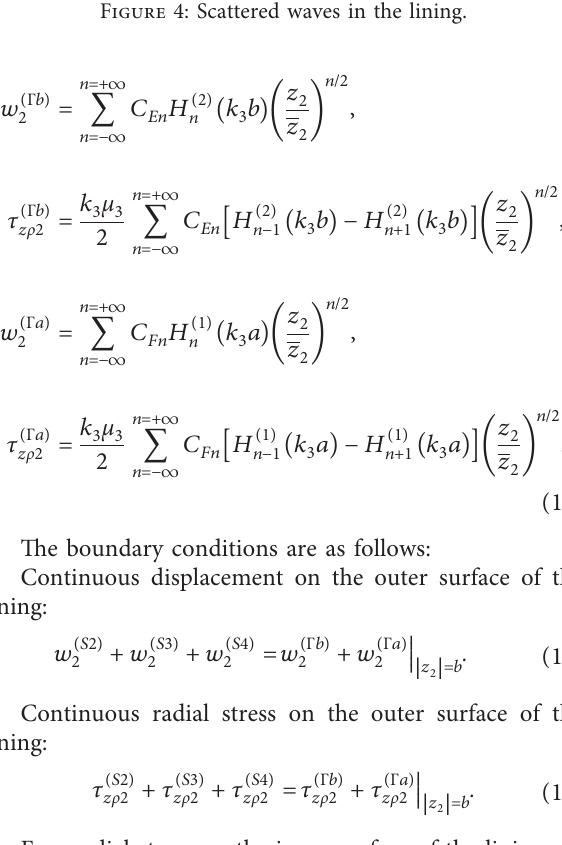
Figure 4: Scattered waves in the